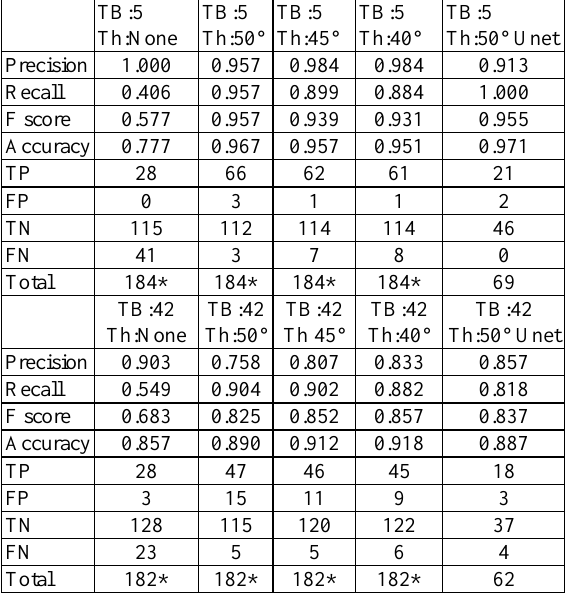
Table 1. Evaluation for Target Building 5 and Target Building 42 with different camera view angle thresholds and final unet